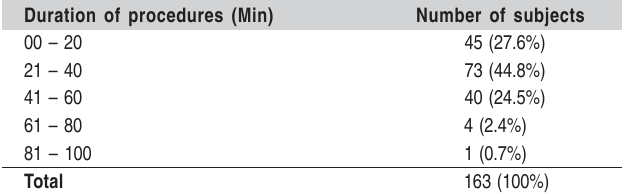
Table 1 - Number of subjects according to the duration of procedures in minutes.